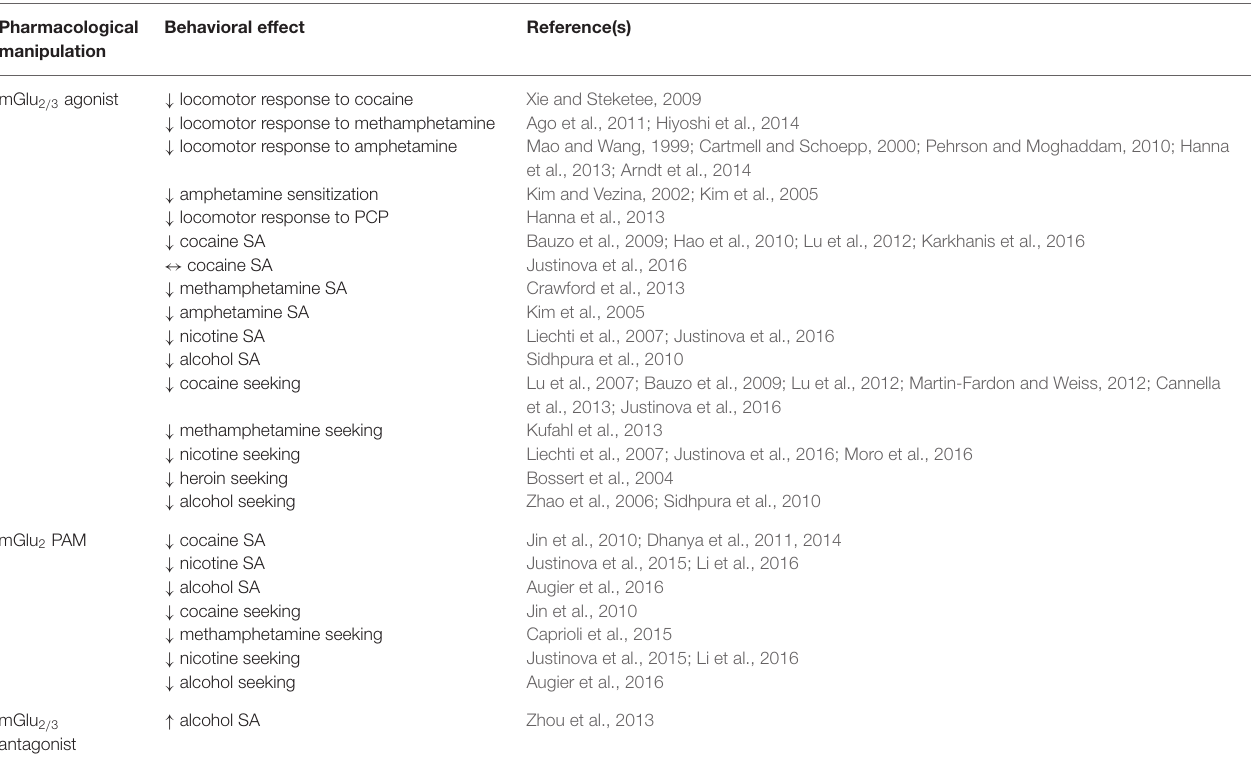
TABLE 3 | Behavioral effects of drugs targeting mGlu 2 / 3